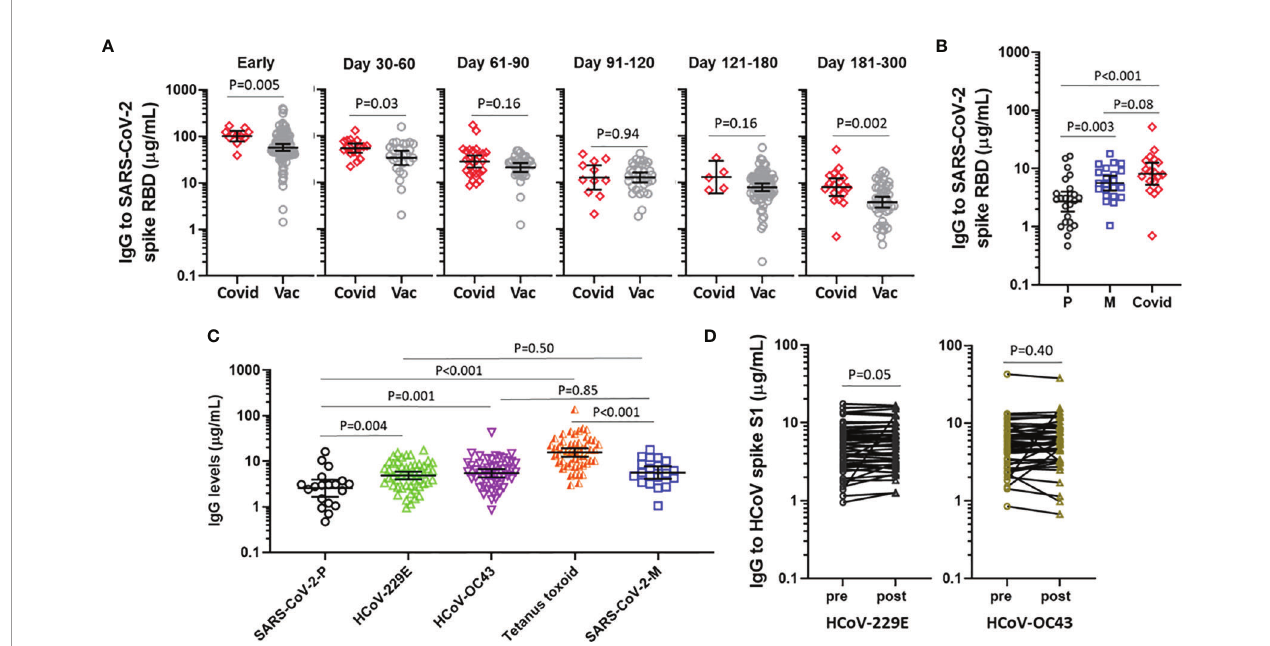
FIGURE 4 | IgG elicited by COVID-19 mRNA vaccines vs COVID-19 natural infection and other representative IgG responses. (A) IgG levels to SARS-CoV-2 spike RBD following natural infection (Covid) and mRNA-vaccination (Vac), strati fi ed by time in relation to symptom onset or time following the second vaccine. (B) IgG levels to SARS-CoV-2 spike RBD at 180-300 days following BNT162b2 (P), mRNA-1273 (M) or natural infection (Covid). (C) IgG to SARS-CoV-2 spike RBD ≥ 6 months following BNT162b2 (P) (n=19) or mRNA-1273 (M) (n=20), compared with IgG to seasonal coronaviruses and tetanus toxoid in 49 representative subjects. Data presented as GM with 95% CI and comparisons with Mann-Whitney U test. (D) IgG to HCoV spike S1 in 49 subjects sampled pre-vaccine and post-boost. Paired log transformed data was compared with the Student ’ s paired T